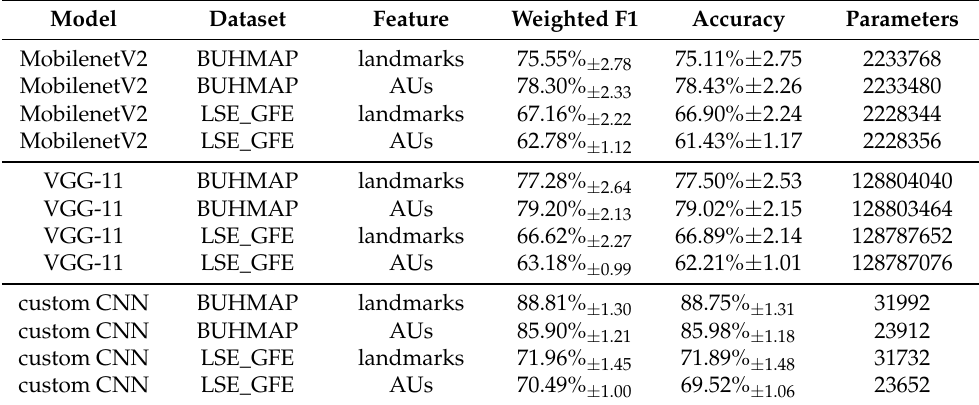
Table 5. Comparative study of classical CNN